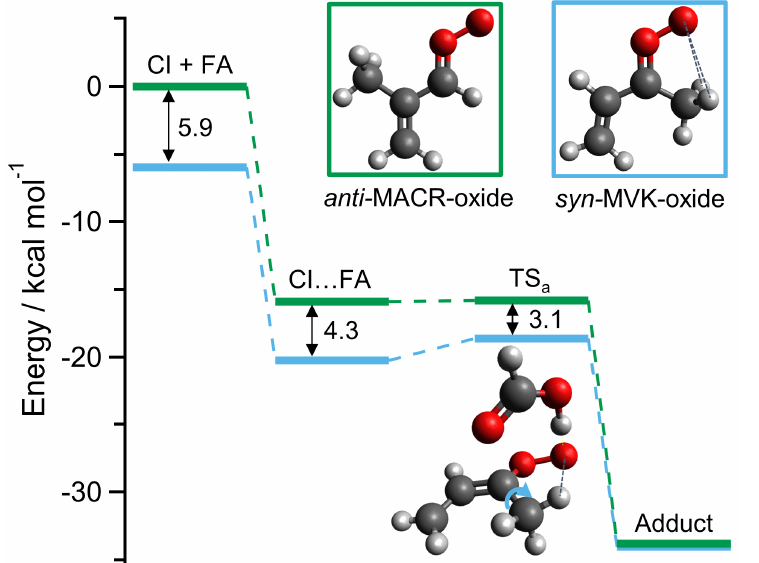
Figure 6. Reaction coordinate comparing the absolute energies for the reaction of formic acid (FA) with anti-trans- MACR-oxide (green) and syn-trans -MVK-oxide (teal) Criegee intermediates (CIs). Energies for the reaction of syn-trans -MVK-oxide are adapted from Ref.[33] with permission from the PCCP Owner Societies. All energies are reported in kcal mol −1 at the CCSD(T)-F12/TZF level of theory.